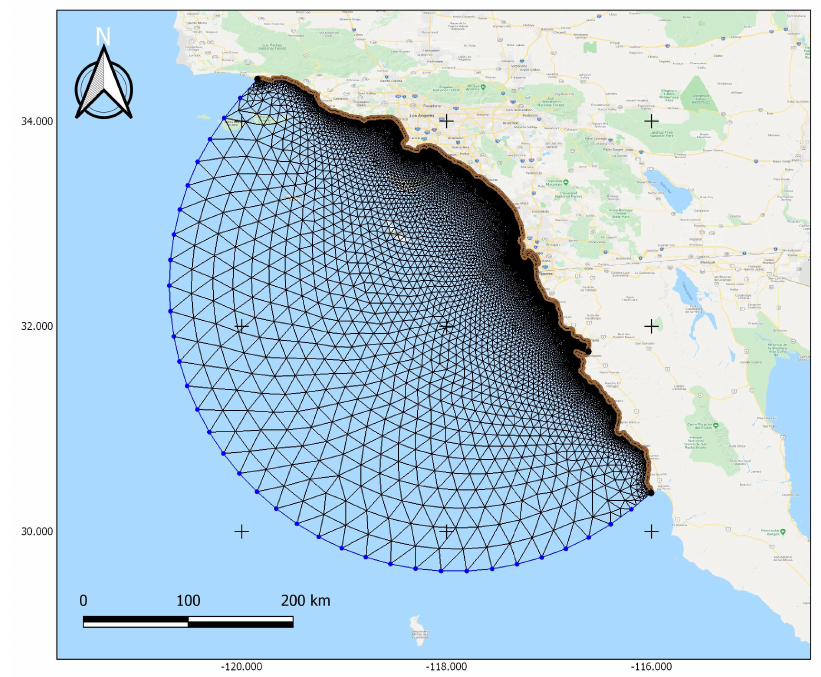
Figure 5. Unstructured mesh of the computational